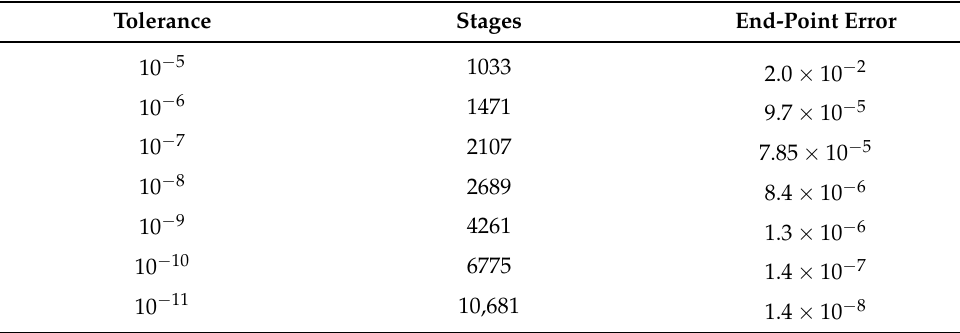
Table 1. Results of DP5(4) over Kepler orbit for γ = 0.6.